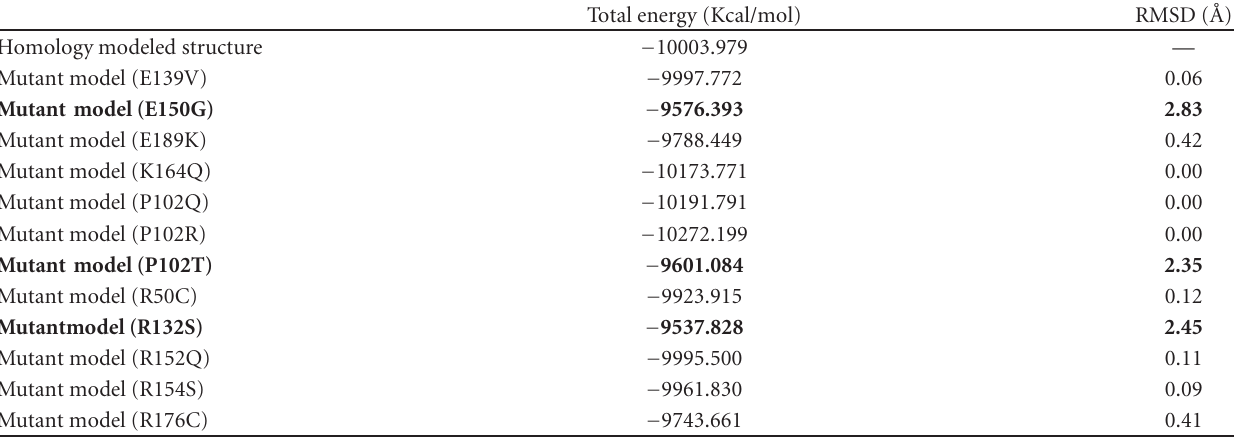
Table 3: RMSD and total energy of modeled structure and its mutant